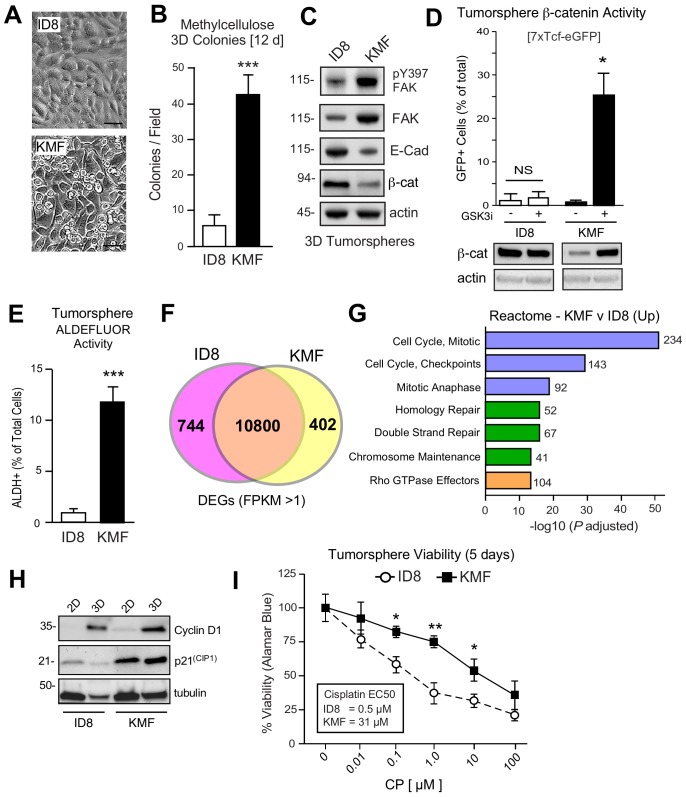
Acquired CSC phenotypes and greater intrinsic cisplatin resistance of KMF cells.(A) ID8 or KMF cells at high densities in 2D culture by phase-contrast imaging. Scale is 25 µm. (B) Quantitation of ID8 and KMF colony formation in methylcellulose (21 days). Values are means (± SEM, ***p<0.001, unpaired T-test) from three independent experiments. (C) ID8 and KMF 3D protein lysates immunoblotted for pY397 FAK, total FAK, E-cadherin, β-catenin, and actin. (D) Lentiviral-delivered β-catenin transcriptional reporter activity (7X TCF-eGFP) in ID8 and KMF cells grown as tumorspheres + /- GSK3β inhibitor. Values are percent GFP+ cells by flow cytometry (NS, not significant, *p<0.05, unpaired T-test, two experiments). Lower, lysates of cells immunoblotted for β-catenin and actin. (E) Quantitation of ID8 and KMF tumorsphere ALDEFLUOR activity. Values are means expressed as fold-change to ID8 (± SD, ***p<0.001, unpaired T-test, three independent experiments). (F) RNA sequencing Venn plot: number of shared or different expressed genes (DEGs) from ID8 and KMF cells in 3D culture. DEGs from FPKM (Fragments Per Kilobase of transcript per Million mapped read) values greater than 1. (G) Partial list of Reactome (top 20) KMF UP DEGs. N is the number of target genes elevated in KMF versus ID8. X axis are -log10 adjusted pP values. (H) Immunoblotting for cyclin D1, p21(Cip1), and tubulin in lysates of ID8 or KMF cells grown in 2D [10% serum] or 3D [serum-free PromoCell, 5 days] conditions. (I) Tumorsphere cytotoxicity (Alamar Blue) with increasing CP (5 days) expressed as percent viability to DMSO control. Means (n = 2) from four independent experiments (± SEM, *p<0.05, **p<0.01 by two-way ANOVA with a Bonferroni’s multiple comparisons test). EC50 values independently determined.10.7554/eLife.47327.009Figure 2—source data 1.Annotated RNA sequencing results from ID8 and ID8-IP/KMF tumorsphere cell lysates.